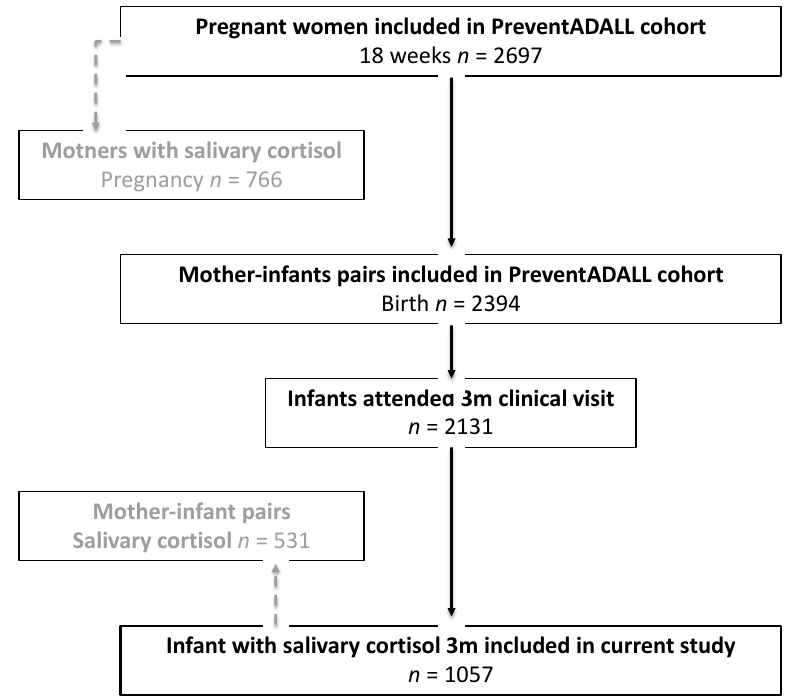
Figure 1. Flowchart of included mothers and infants.